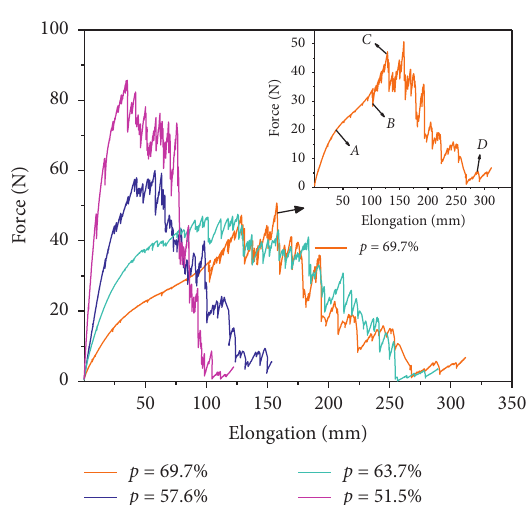
Figure 13: Force-elongation curves of specimens with different porosities.